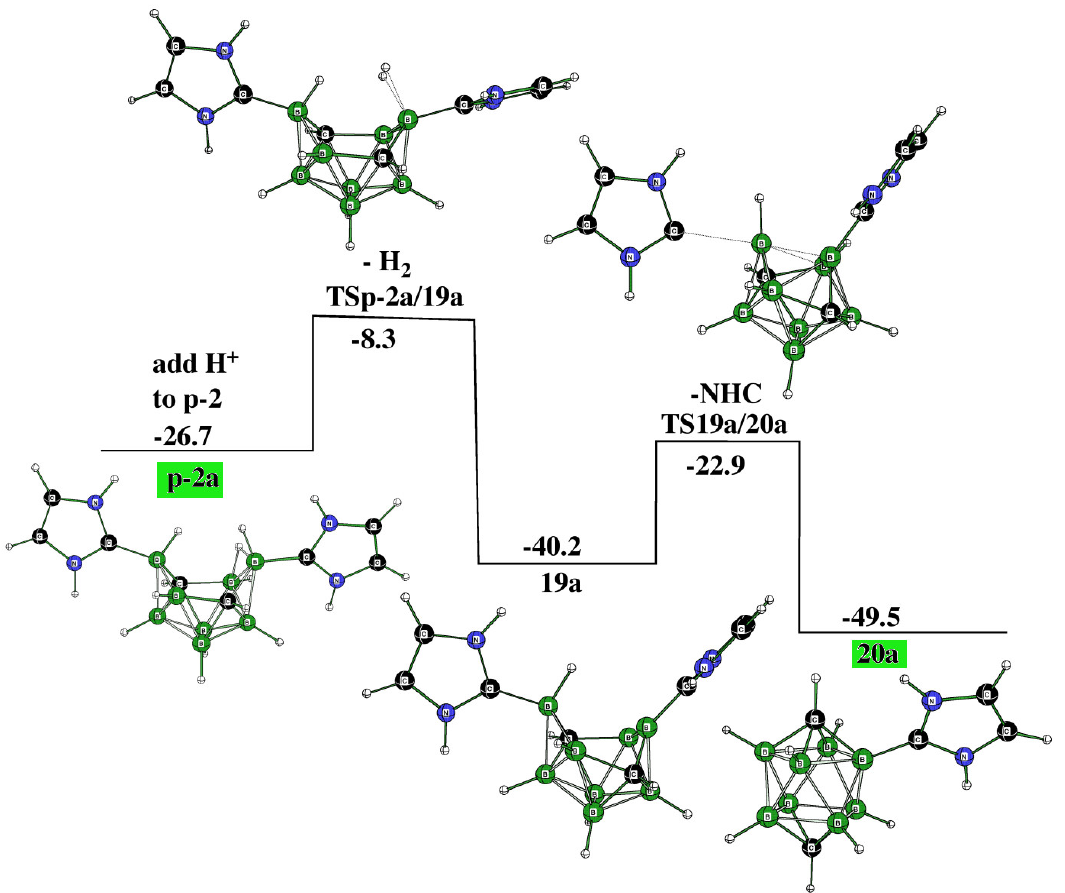
Figure 7. Relative free energies (kcal.mol − 1 ) of the individual stationary points on the potential energy surface (PES) of the entire protonation of “p-2a” (see Tables 1 and S1 and Section 3 for details).